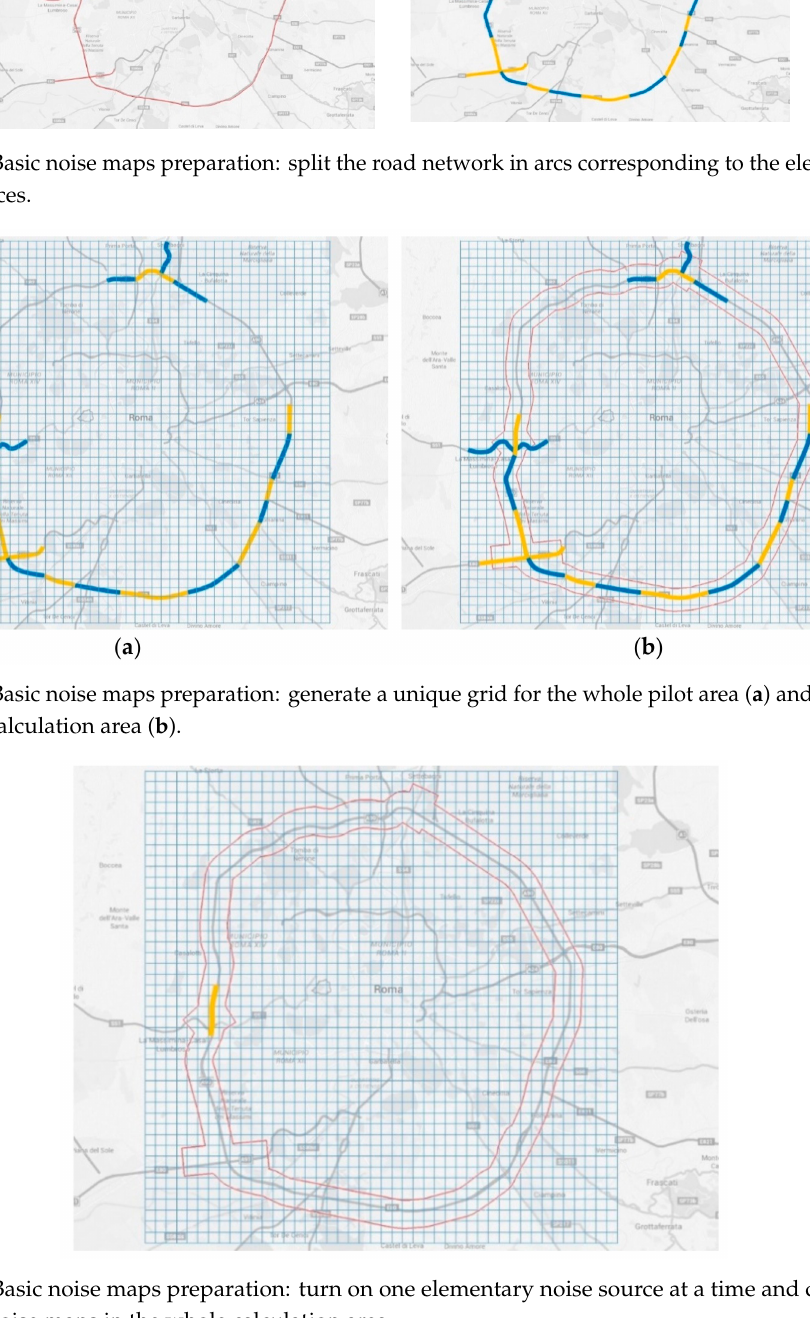
Figure 6. Basic noise maps preparation: turn on one elementary noise source at a time and calculate the basic noise maps in the whole calculation